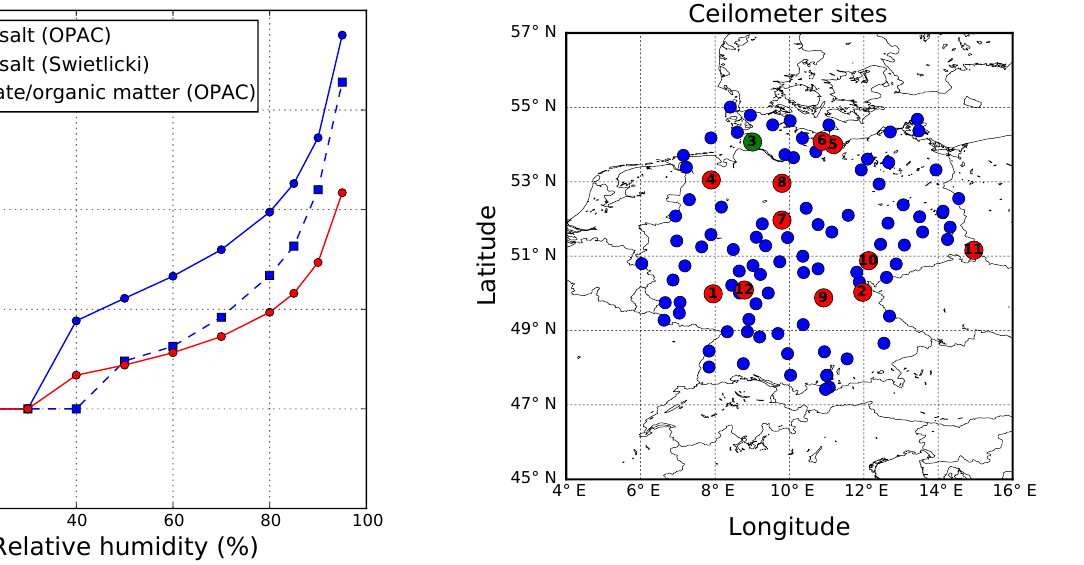
Figure 1. Hygroscopic growth factors of particle radius of sea salt, sulfate and hydrophilic organic matter aerosols as a function of rela- tive humidity. Sulfate and hydrophilic organic matter share the same growth factor in the model (red curve). Growth factors of sea salt obtained from Swietlicki et al. (2008) are also shown for reference.